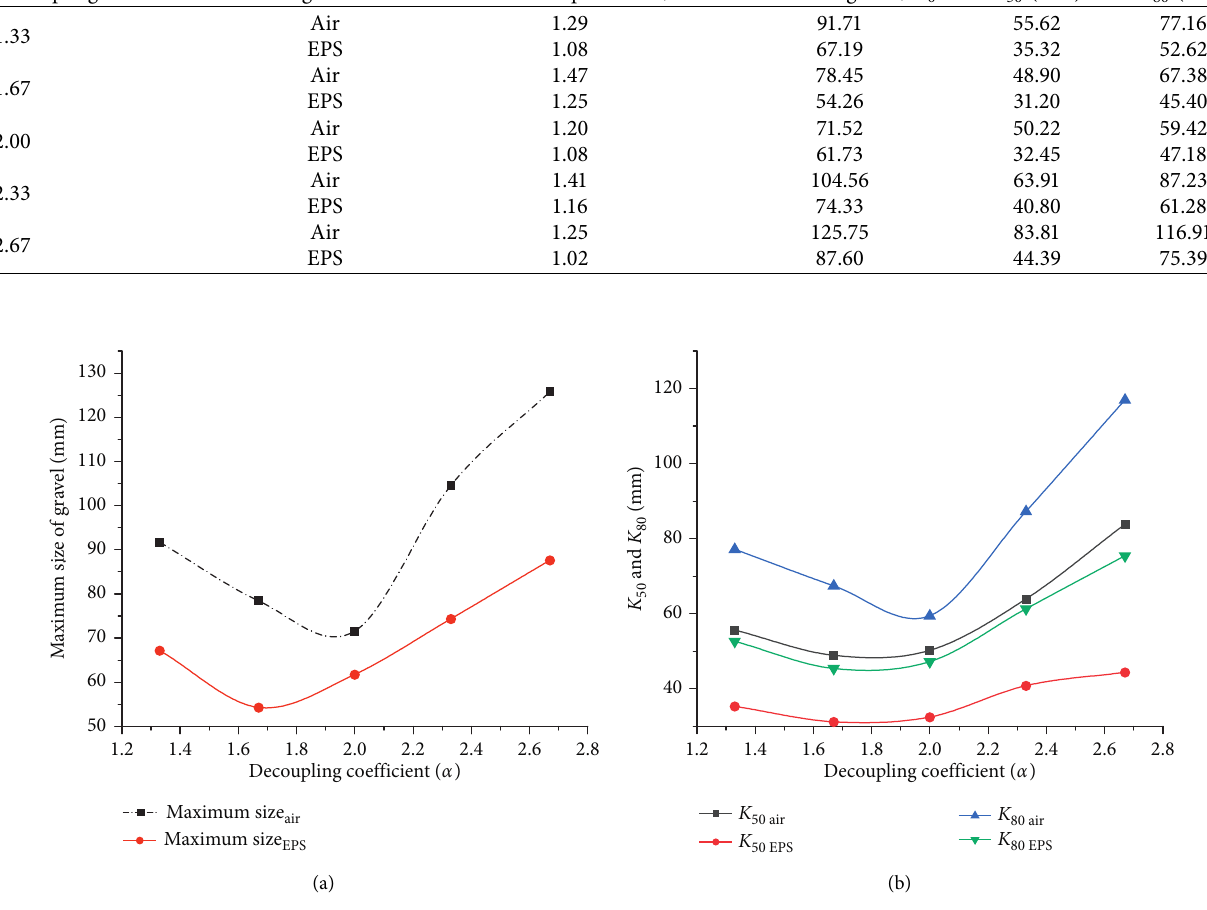
Figure 10: Relationship between the decoupling coefficient and (a) the maximum gravel size and (b) K